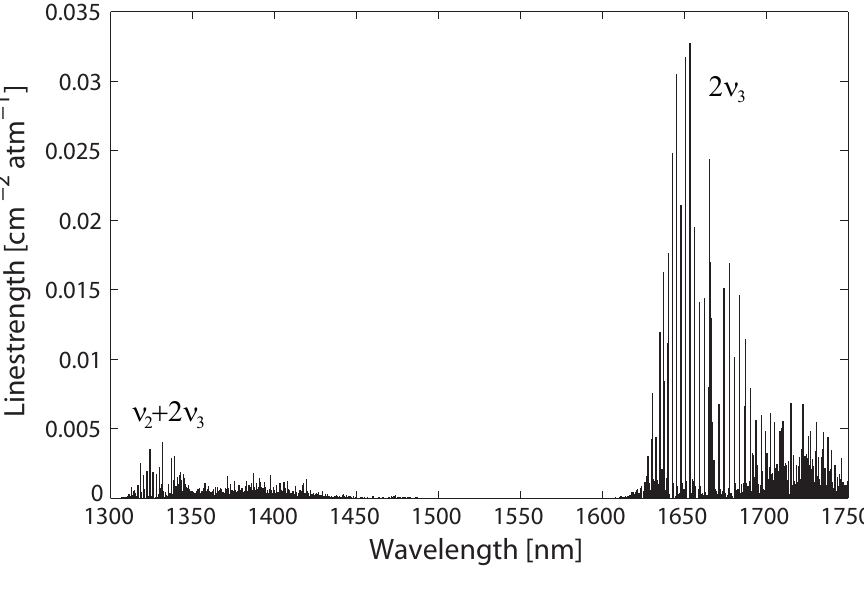
Figure 1. Linestrengths of the ν Reproduced from